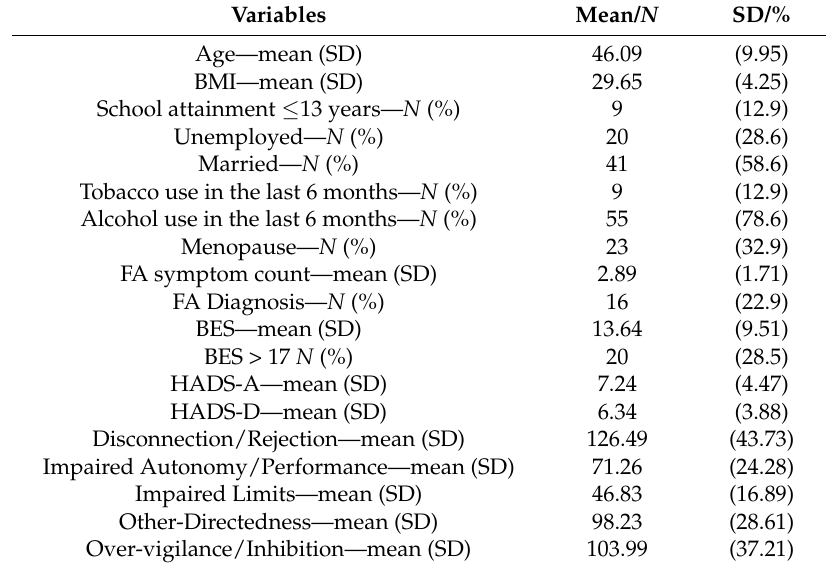
Table 1. Descriptive statistics for the sample ( N =